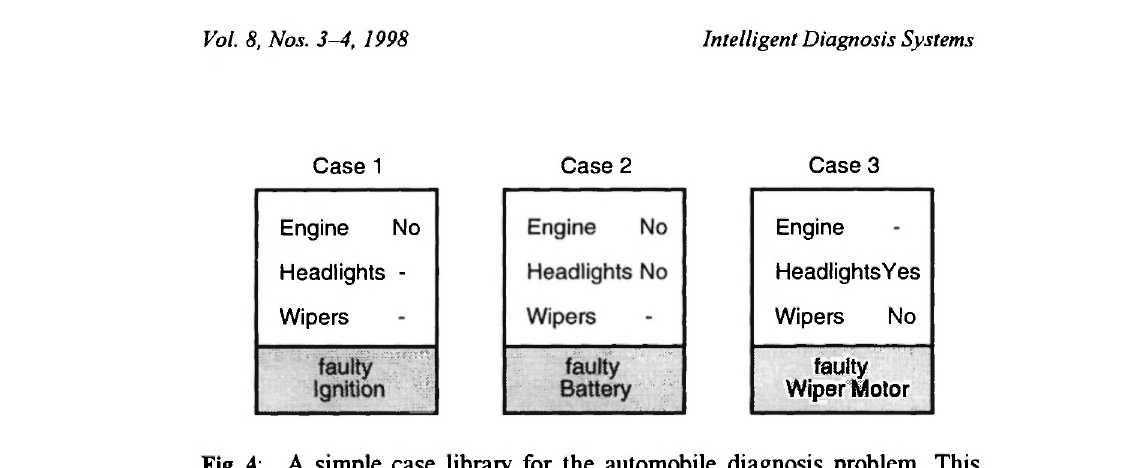
Fig. 4: A simple case library for the automobile diagnosis problem. This library contains three cases corresponding to past diagnoses. In addition to using Yes and No to denote working and non-working components, the system also uses - to indicate the unknown status